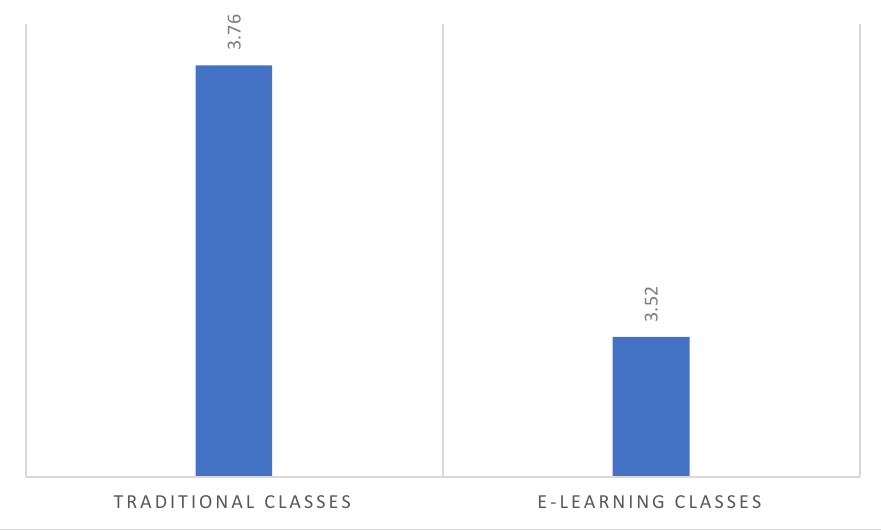
Figure 6. The ease of content acquisition in the case of traditional and e-learning classes.